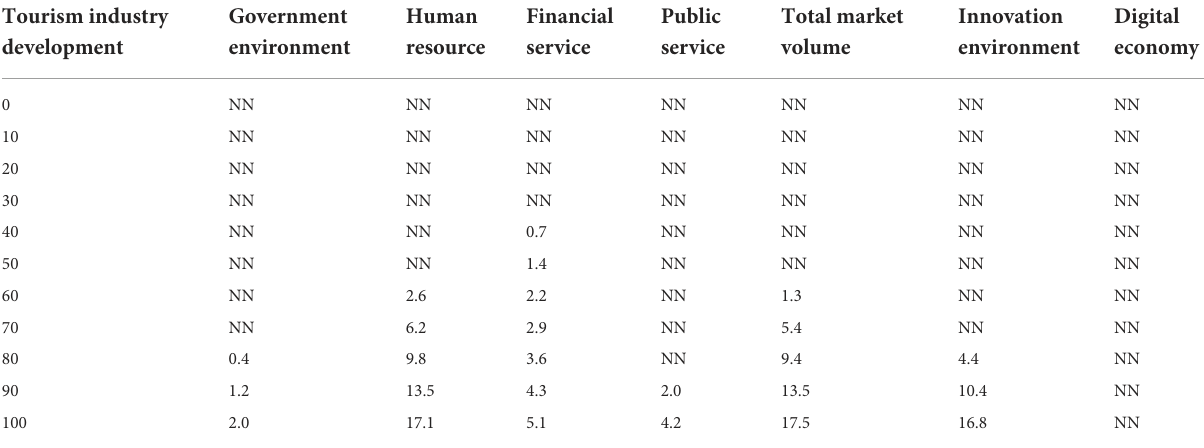
TABLE 4 Bottleneck level analysis of the NCA method.